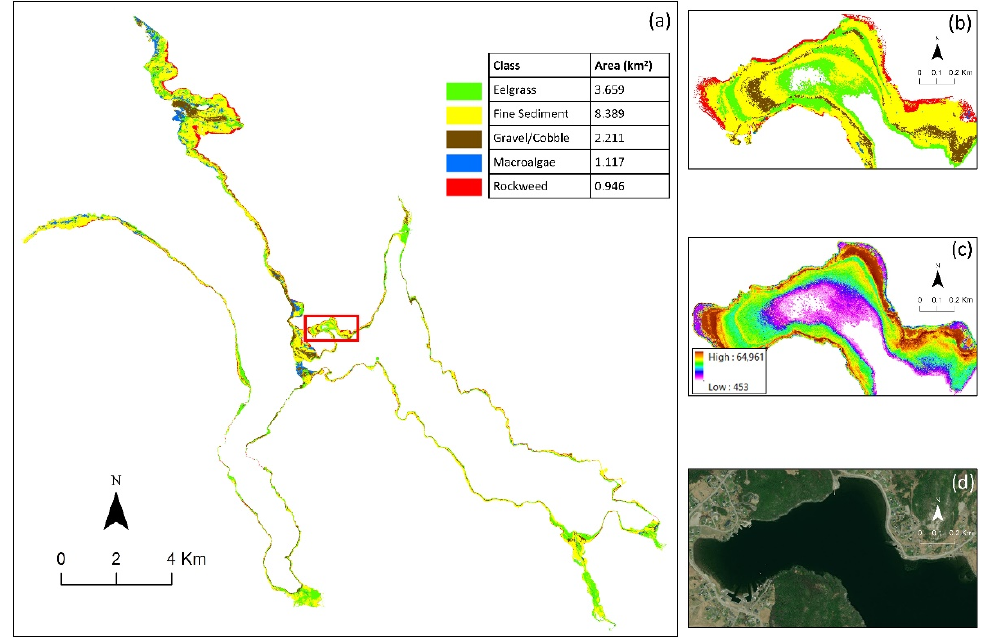
Figure 8. ( a ) Habitat map of Bonne Bay based on the Category-2 classes. ( b ) A zoomed area (red boundary in ( a )) from the map along with the ( c ) LiDAR intensity image and ( d ) very high-resolution Google Earth imagery to demonstrate the visual accuracy of the